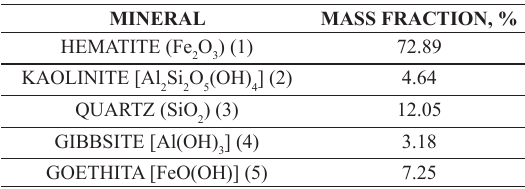
Table 2. Mineralogical composition of the iron ore sample (% by mass fraction).